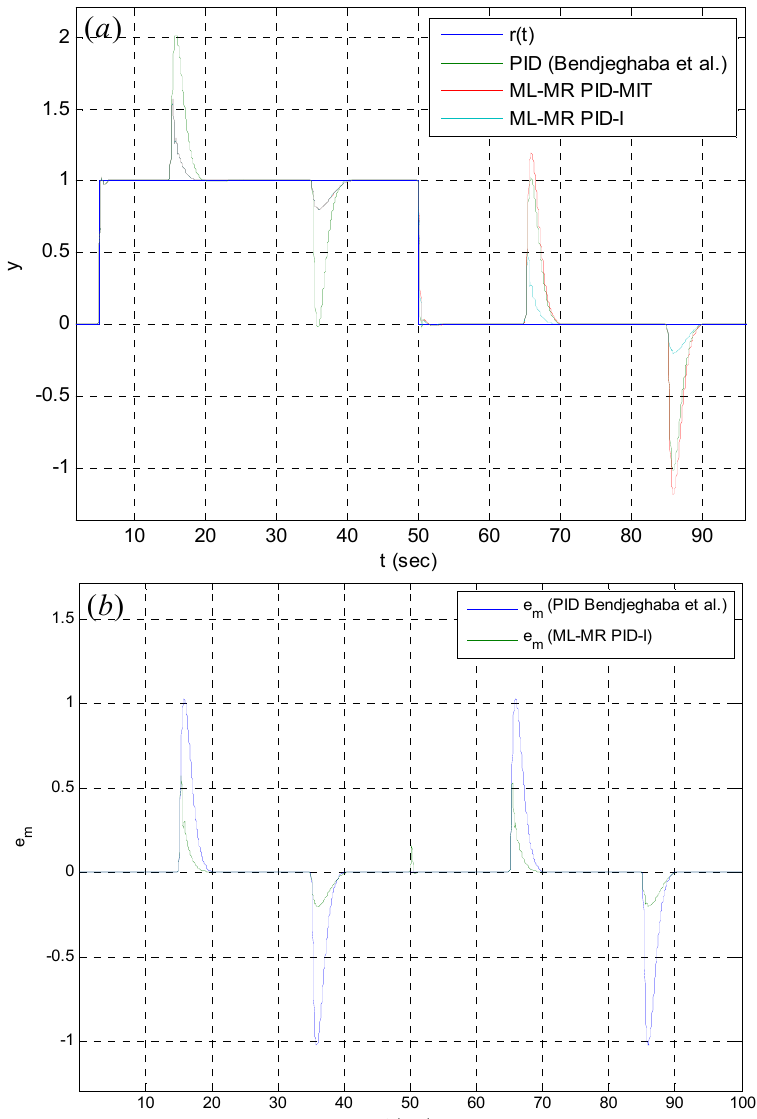
Figure 10. Improvement of the disturbance rejection performance of the classical optimal PID loop by the proposed ML-MR PID-I control structure for the model. ( a ) Step response and ( b ) change of model error